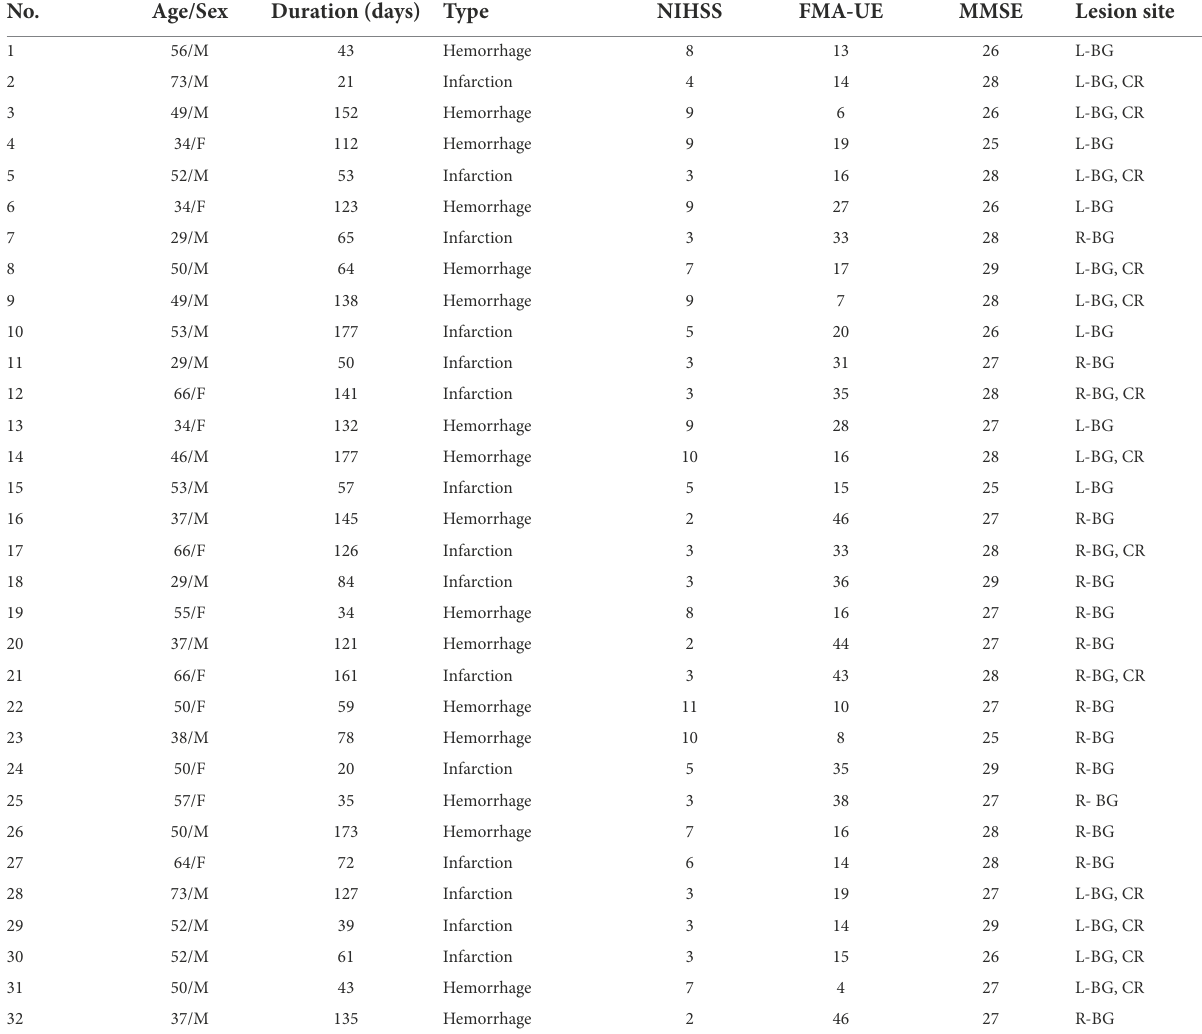
TABLE 1 Clinical characteristics of stroke